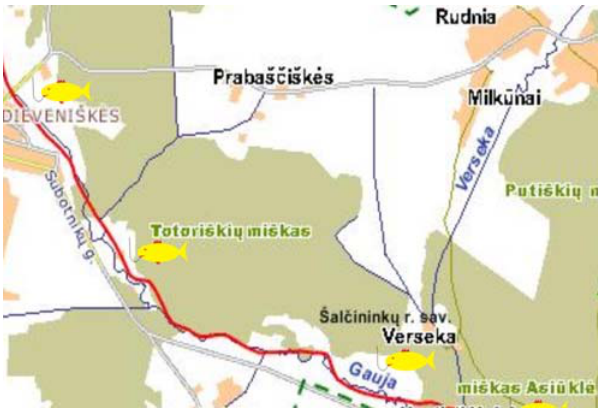
Fig. 2. Stone loach collecting sites in the Gauja stream near Dieveniškiai in Šal č ininkai district in 2007